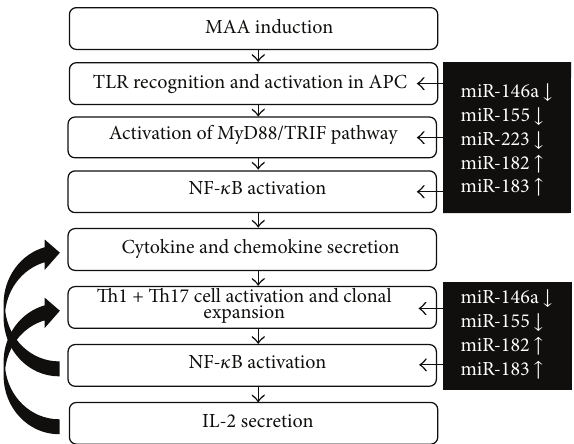
Figure 8: Proposed pathogenesis and respective regulations of microRNAs in EAAU. TLR: toll-like receptor; MyD88: myeloid differentiation marker 88; TRIF: TIR domain-containing adapter inducing IFN-beta; APC: antigen presenting cells; EAAU: experi- mental autoimmune anterior uveitis; IL: interleukin; NF- 𝜅 B: nuclear factor kappa B; IFN: interferon; MAA: melanin-associated antigen.